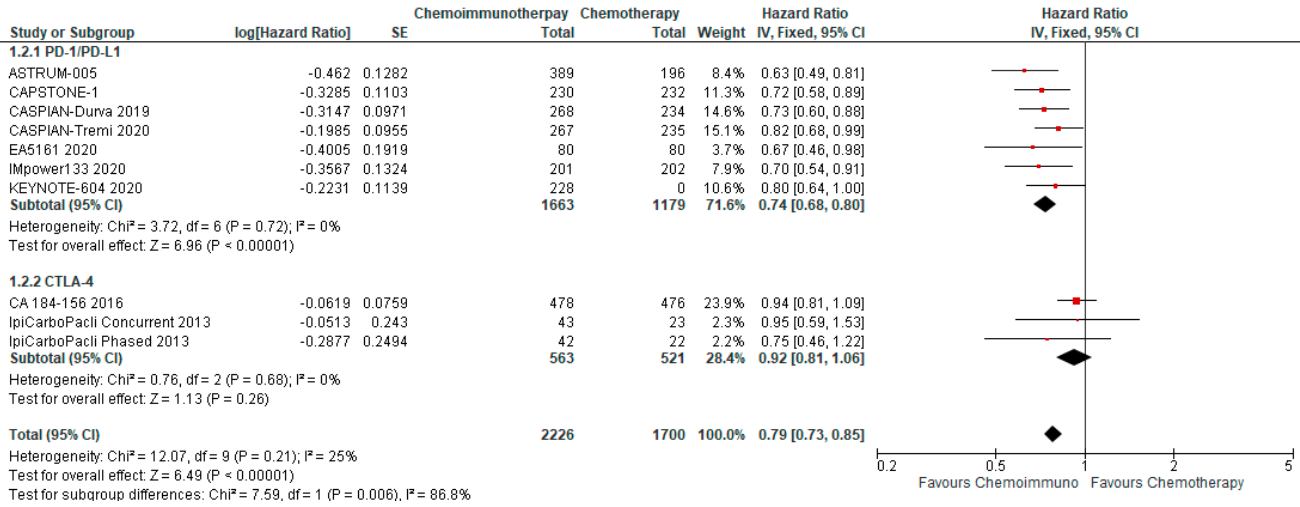
Figure 2. Forest Plot of hazard ratios for overall survival of patients with ES-SCLC and treated with chemo-ICI versus standard chemotherapy. PD–1/PD–L1, programmed death (ligand)–1; CTLA–4, cytotoxic T-lymphocyte-associated protein 4; HR, hazard ratio; CI, confidence interval; IV, inverse variance.